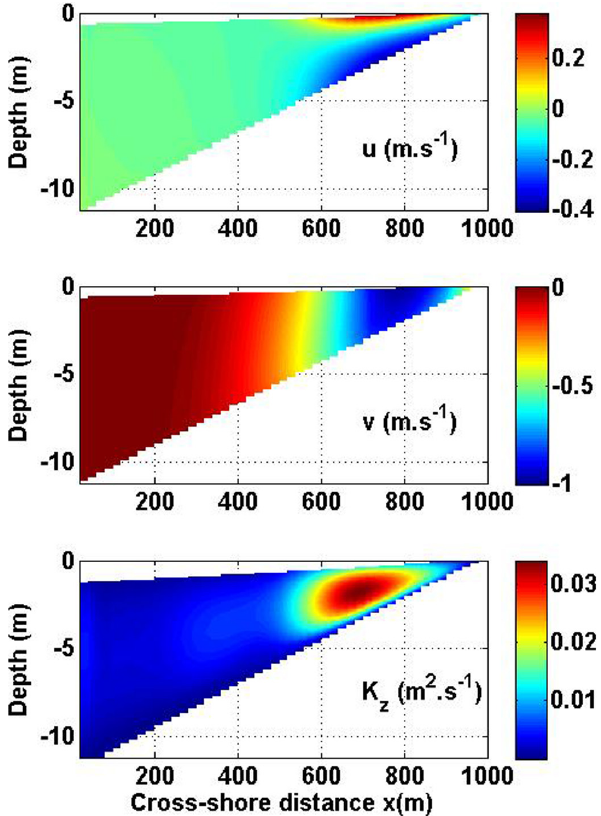
Fig. 1. Cross-shore profile of the surface elevation (a) , barotropic quasi-Eulerian cross-shore (b) and longshore (c) velocities (ms − 1 ) (adapted from UMS10). SYMPHONIE results are the red dashed line whereas ROMS results of Run b are in black dashed lines. The shoreline is at right.